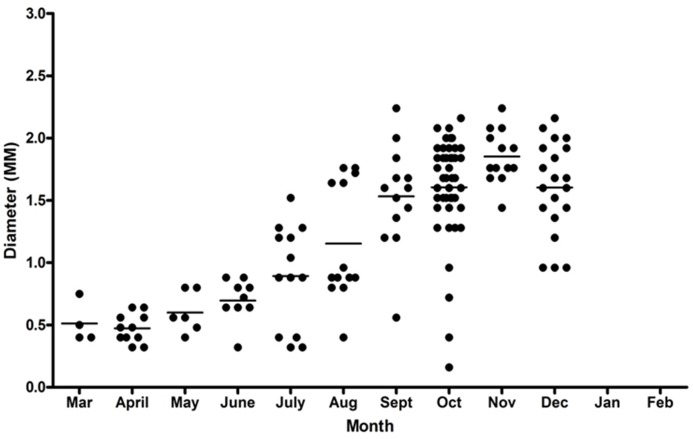
Diameters of blastocysts each month.Distribution of blastocyst diameters by month. The horizontal line indicates the mean blastocyst diameter for that month.